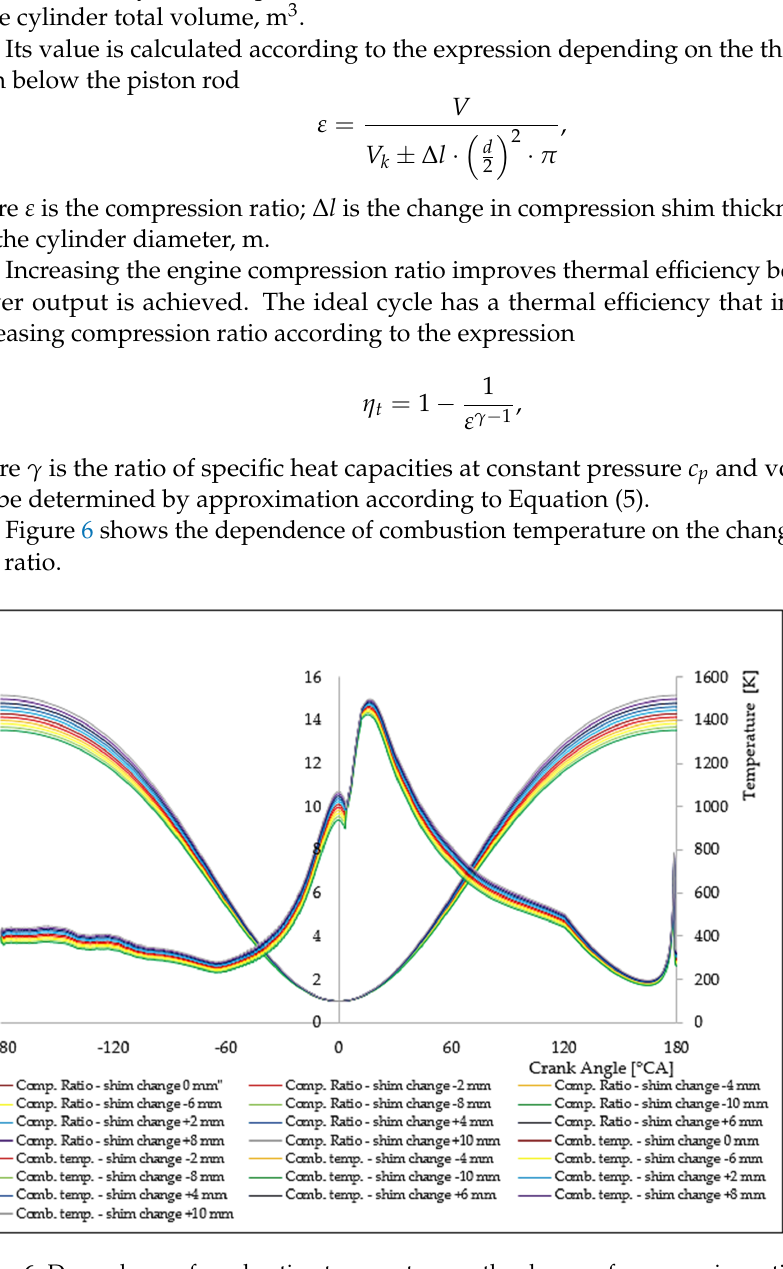
Figure 6. Dependence of combustion temperature on the change of compression ratio [22].